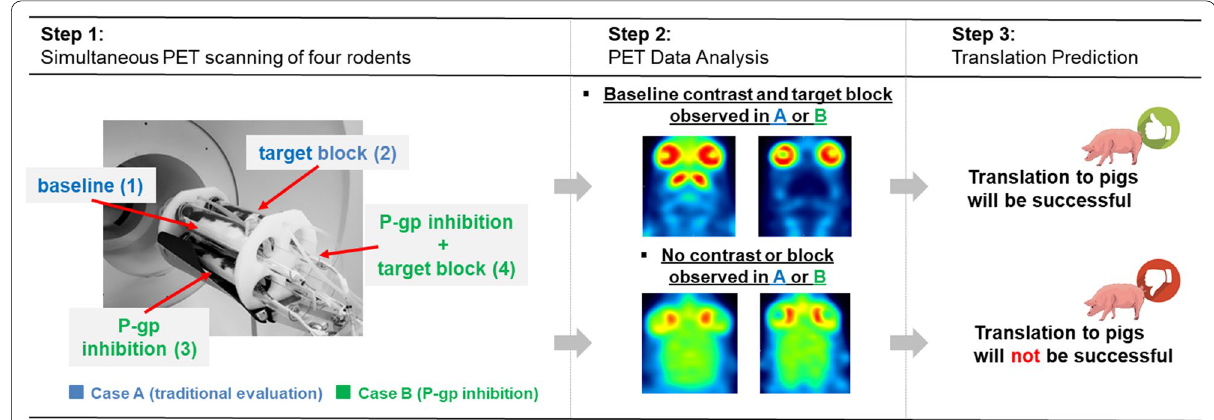
Fig. 1 Tracer evaluation strategy. Step 1 and 2 : Traditionally, specific binding can be determined by comparing tracer uptake at baseline and after target block ( Case A ). This work proposes to perform the same two experiments with simultaneous inhibition of P-gp ( Case B ). Step 3 : If specific binding is observed in Case A or B, a successful translation from rodent to pig is